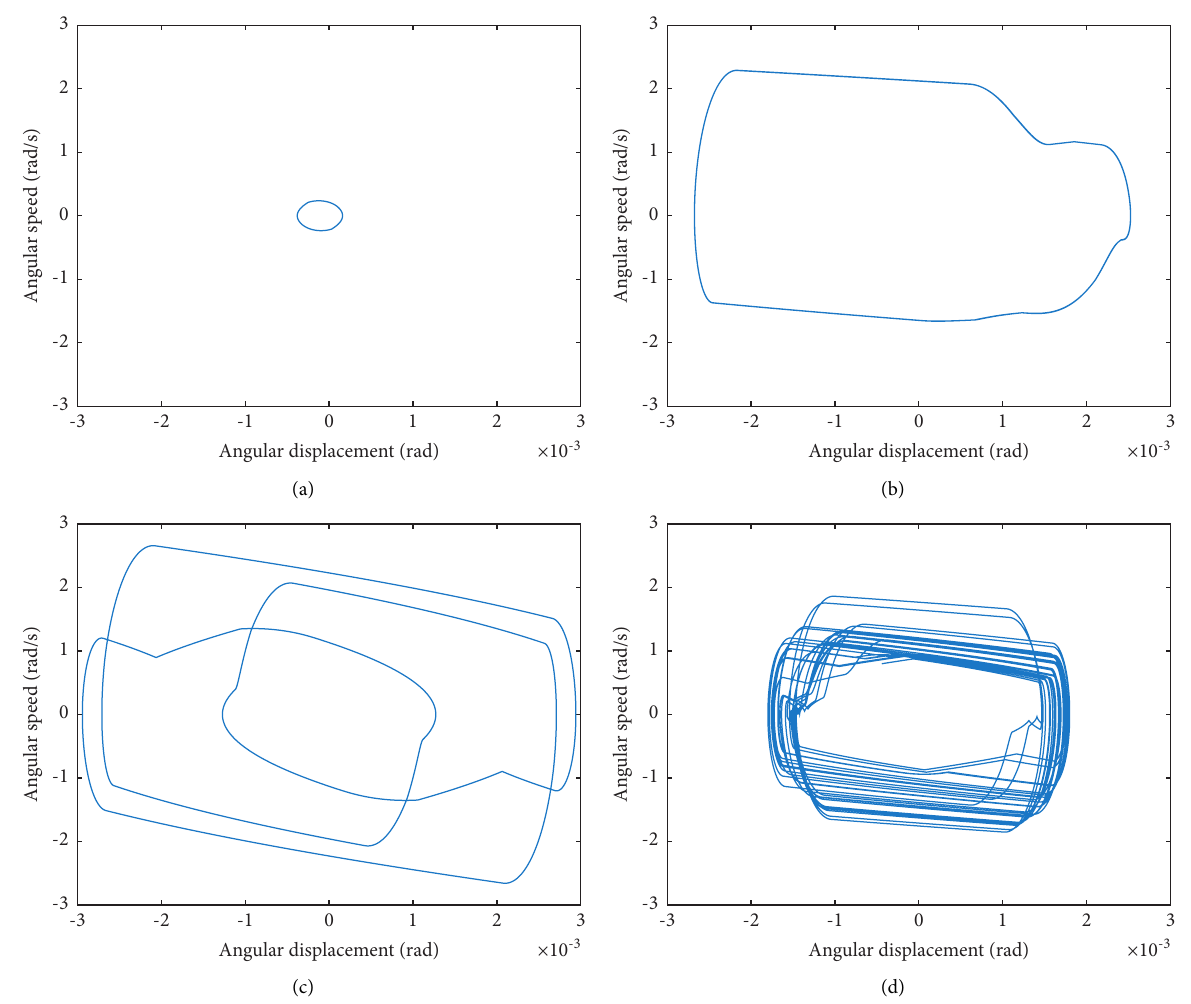
Figure 14: Phase space of the shock-friction damper for different steady-state solutions (various excitation amplitudes of the underlying structure) (a) limit cycle without shocks, (b) T-periodic limit cycle with shocks, (c) 3T-period, and (d) not periodic attractor.